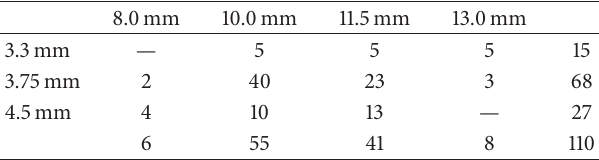
Table 1: Implant distribution by length and